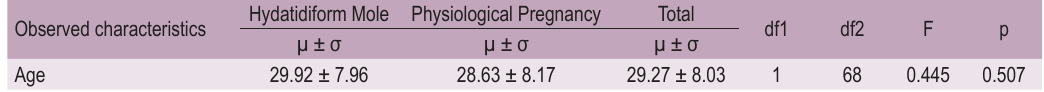
TABLE 2. Number and characteristics of patients according to parity and group Parity